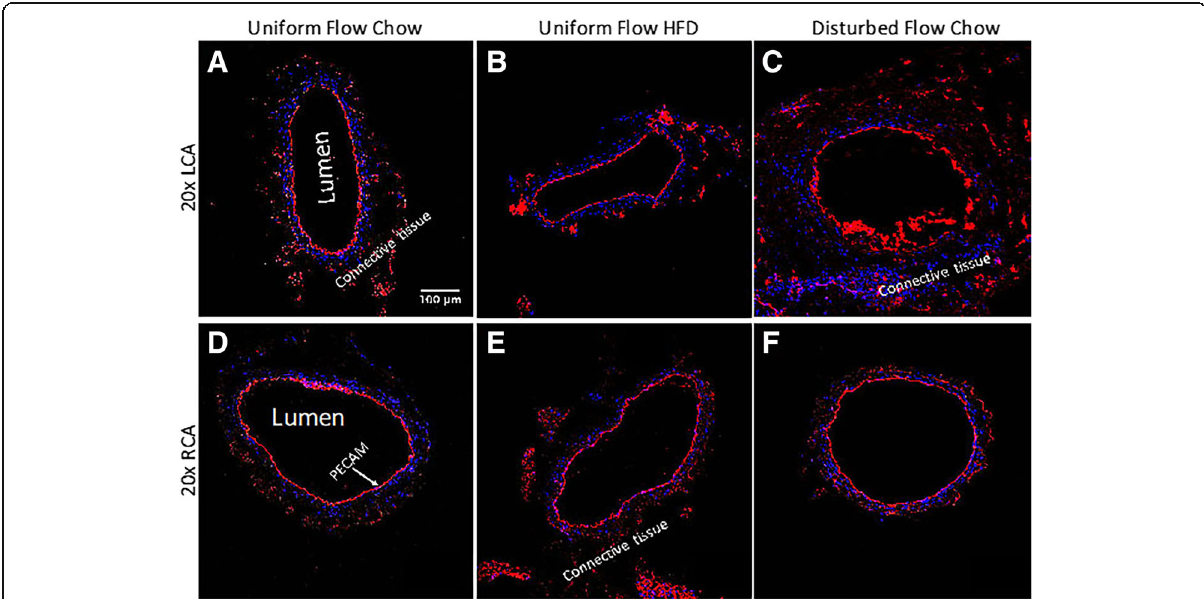
Fig. 3 LCA and RCA vessels are immunostained for PECAM (red) to demonstrate the integrity of the endothelial cell layers on the inner vessel walls. Blue signifies DAPI labeled cell nuclei. a 20x image of the LCA obtained from an ApoE-KO mouse with a regular chow diet and exposed to uniform blood flow patterns. b 20x image of the LCA from an ApoE-KO mouse fed an HFD and exposed to uniform flow. c 20x image of the LCA from an ApoE-KO mouse on a regular chow diet and exposed to disturbed blood flow due to partial ligation. d 20x image of the RCA obtained from an ApoE-KO mouse with a regular chow diet. This RCA was exposed to uniform blood flow while its corresponding LCA was also exposed to uniform blood flow. e 20x image of the RCA from an ApoE-KO mouse on an HFD. This RCA was exposed to uniform blood flow while its corresponding LCA was also exposed to uniform blood flow. Finally, f 20x image of the RCA from an ApoE-KO mouse on a regular chow diet. This RCA was exposed to uniform blood flow while its corresponding LCA was exposed to disturbed blood